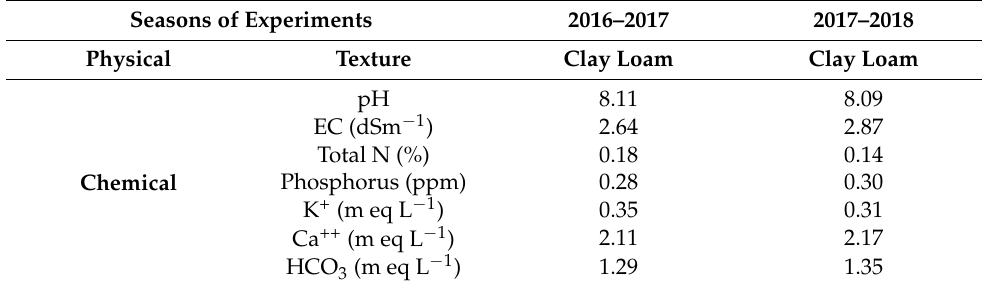
Table 1. Pre-experiments soil characterization, during two growing seasons: 2016–2017 and